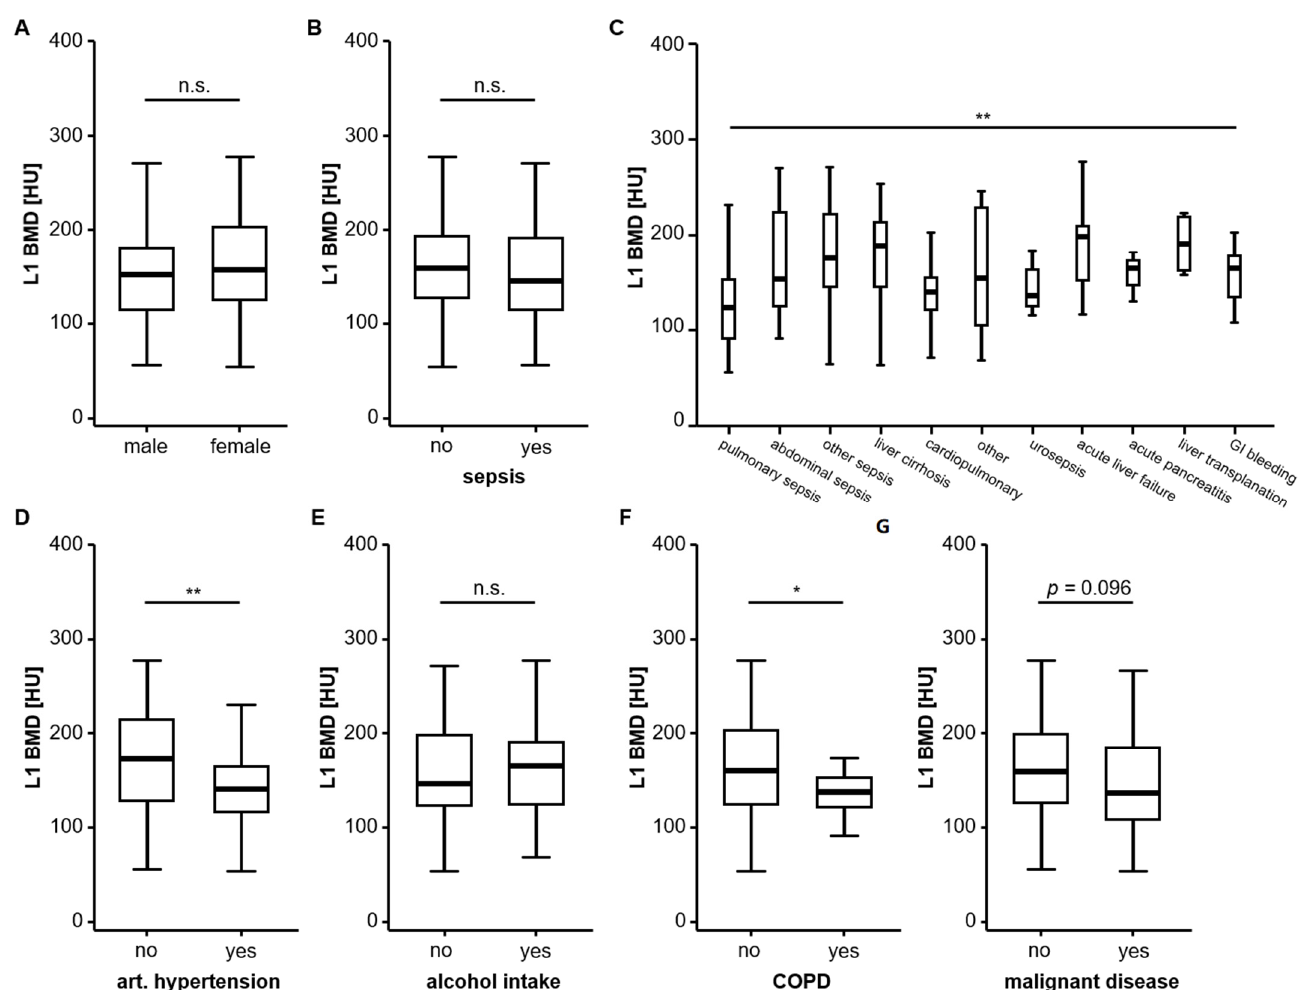
Figure 2. Bone mineral density (BMD) and patient characteristics. Male and female patients ( A ) and patients who did or did not fulfil the criteria of sepsis ( B ) have a comparable BMD. ( C ) BMD significantly differed between patients with different disease aetiologies that led to ICU admission. ( D ) BMD is significantly lower in patients with pre-existing arterial hypertension but comparable between patients with or without chronic alcohol intake ( E ). Patients with pre-existing chronic obstructive pulmonary disease (COPD) have significantly lower BMD values ( F ) and patients with pre-existing malignant disease show a strong trend towards lower BMD values ( G ). *: p < 0.05, **: p < 0.01